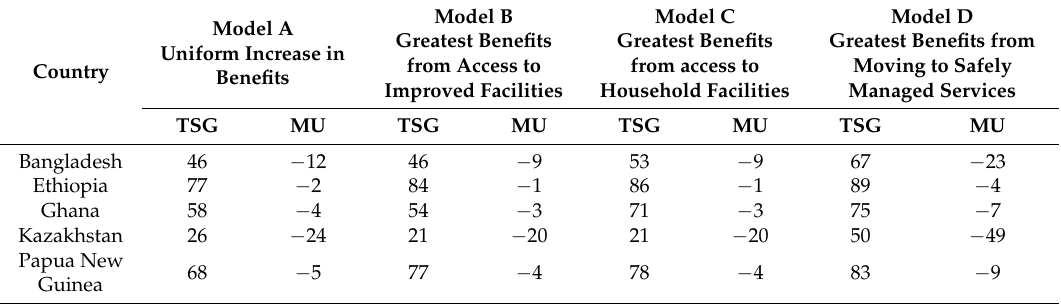
Table 3. Total service gap (TSG) and margin of uncertainty (MU) for selected countries using Models